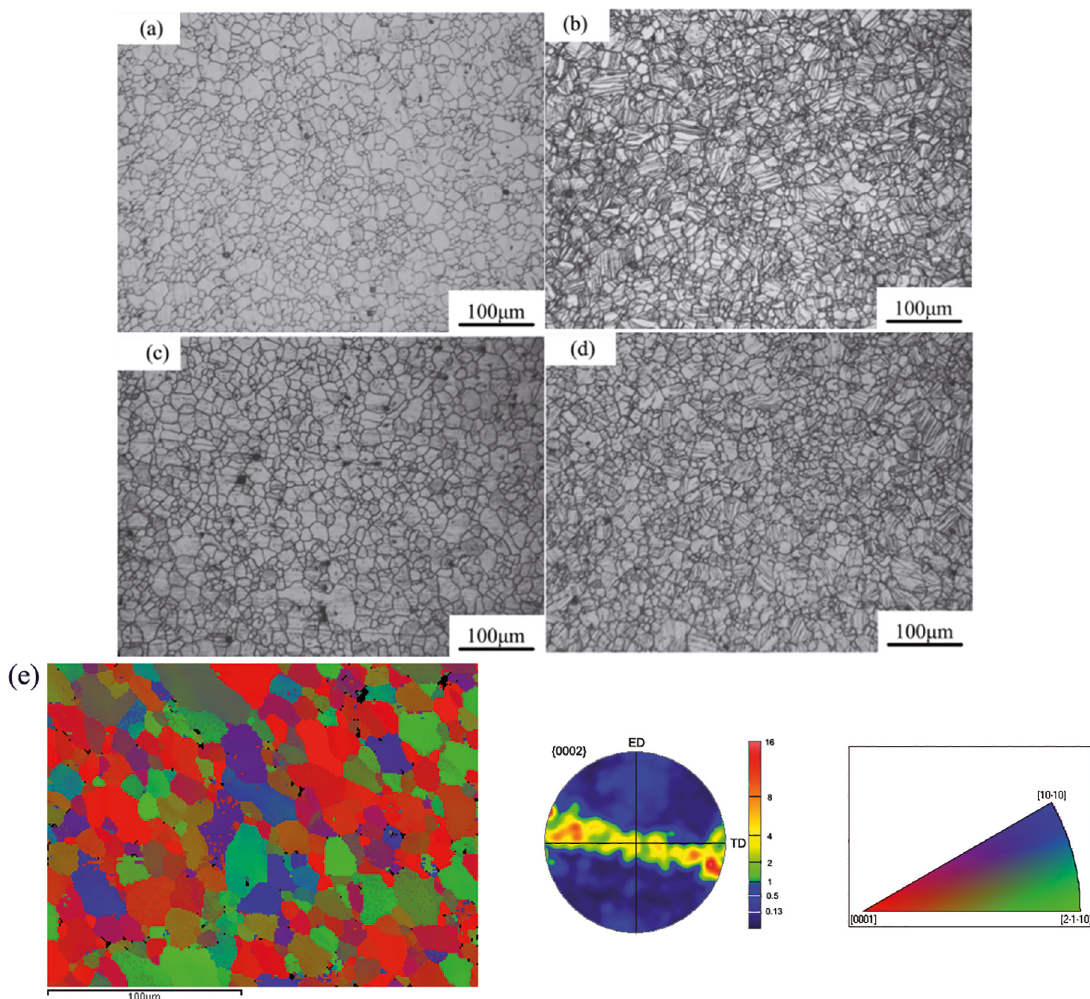
Figure 6. Evolution of microstructures during pre-stretch on AZ31 Mg alloy billets: (a) 1 st prs3%, (b) 1 st inverse compression 3%, (c) 2 nd prs 3%, (d) compression to fracture, (e) EBSD maps of 1 st prcs%